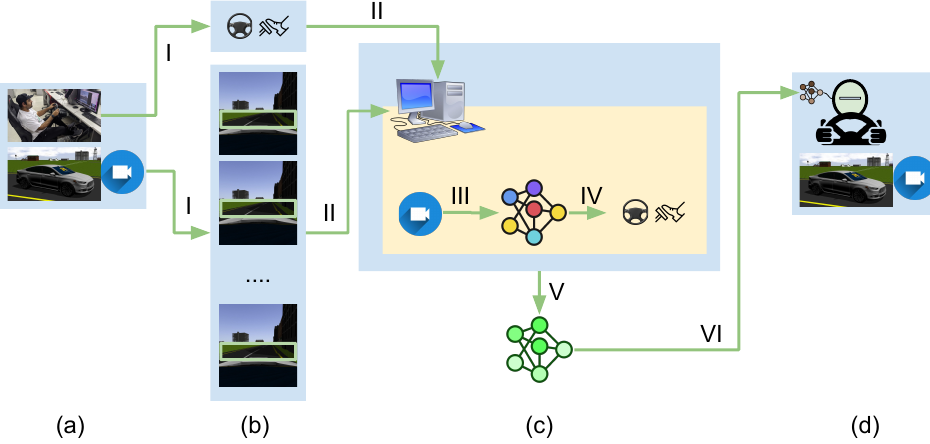
Figure 2. End-to-end driving. ( a ) A human driver drives a vehicle as we collect driving data. ( b ) The driving data including the front camera images with synchronized control signals are saved in storage. The collected data must have all necessary features that can be expected in a testing phase of the neural network. ( c ) The training station where a neural network is trained with the collected data to associate input with output. ( d ) The trained neural network is deployed to the AI chauffeur who drives the vehicle using inferred steering angles, throttle, and